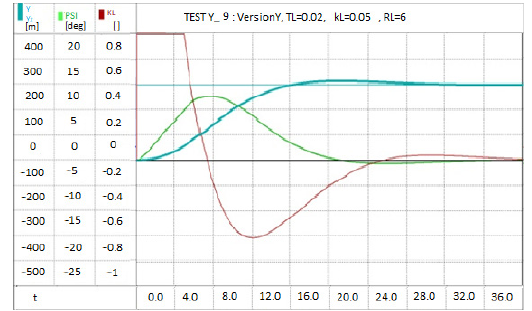
Figure 7. The transitional process of controlling flight direction Y z , with preset step changes to the coordinate Y from 0 to 300 metres. Testing the influence of the co-efficient of reinforcement K L = 0.005 with unchanged value of the derivative constant of R L = 6